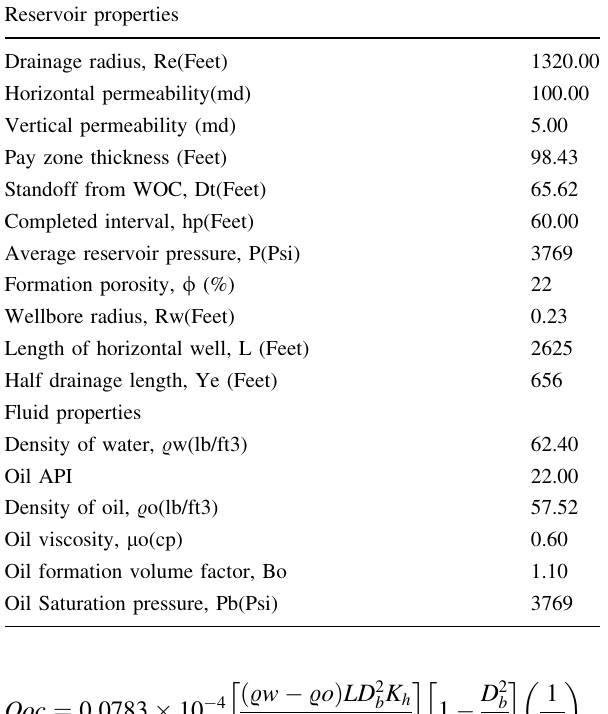
Table 2 CFPR calculation results from the various